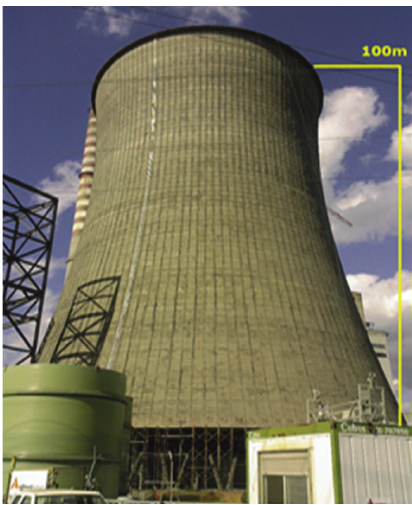
Figure 1: Cooling tower unit III of Megalopolis.